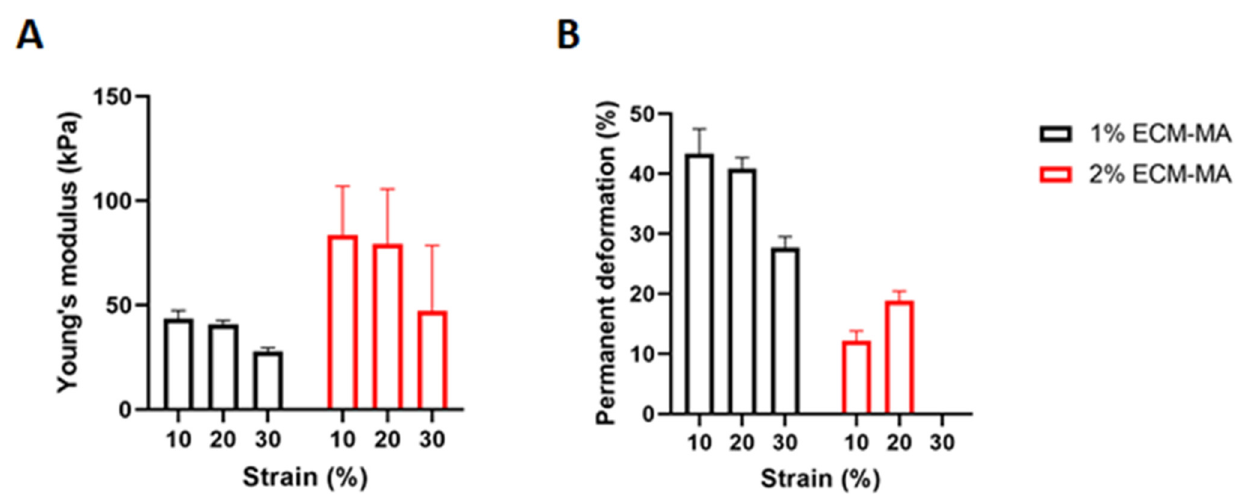
Figure 5. Compression testing of photocrosslinked cECM-MA hydrogels ( n = 3). ( A ) Young’s modulus of compression (unconfined). ( B ) Permanent deformation due to compression.